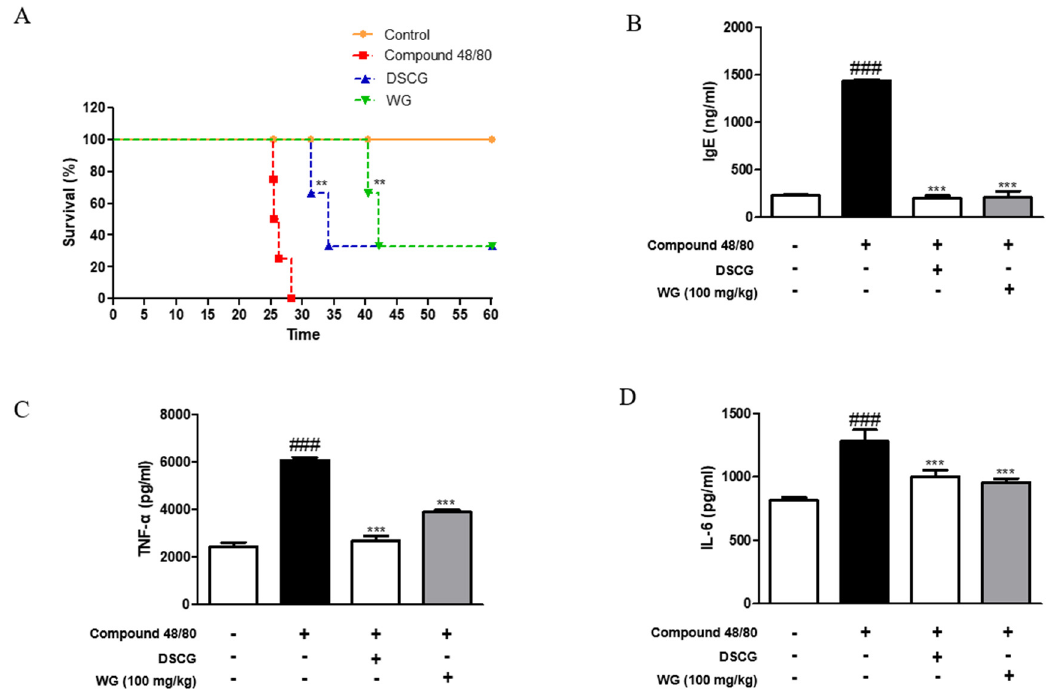
Figure 1. Effects of WG on compound-48/80-induced mortality and inflammatory cytokine production in anaphylaxis shock animal model. ( A ) Survival rates of mice were monitored for 1 h. ( B ) IgE serum levels were measured using ELISA kit. ( C ) TNF- α and ( D ) IL-6 cytokine production from serum was measured using ELISA kit. The data shown represent means ± S.D. of three independent experiments. Note: ### p < 0.001 vs. the control group; ** p < 0.01 and *** p < 0.001 vs. compound 48/80-treated group. DSCG; disodium cromoglycate.